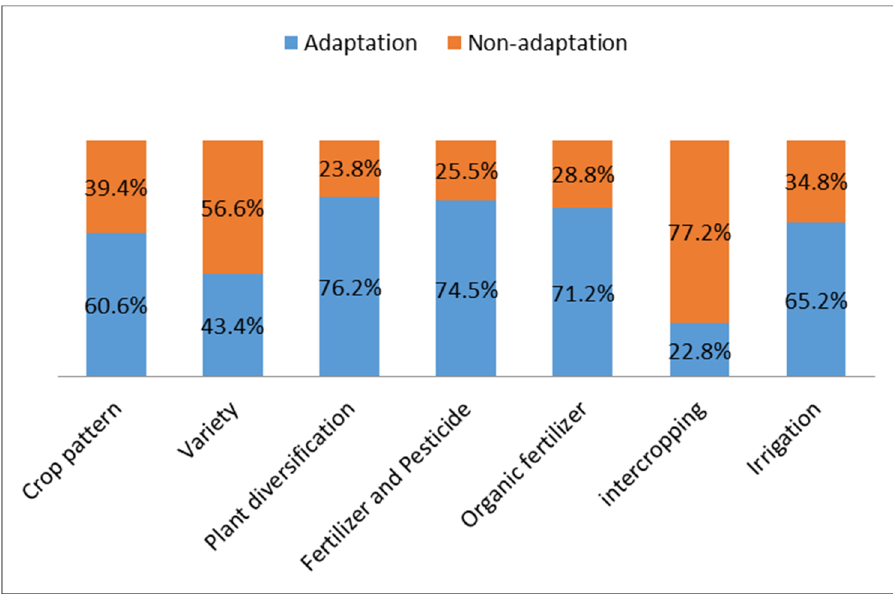
Figure 2. On-farm adaptation practices.